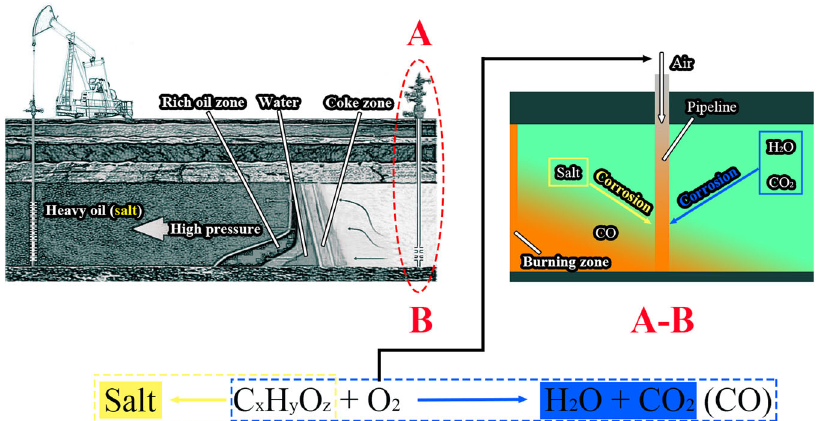
Fig. 1 The schematic diagram. The fi re fl ooding technology and the reaction of pipeline steel with the oxidation products after fl ue combustion ( A , B